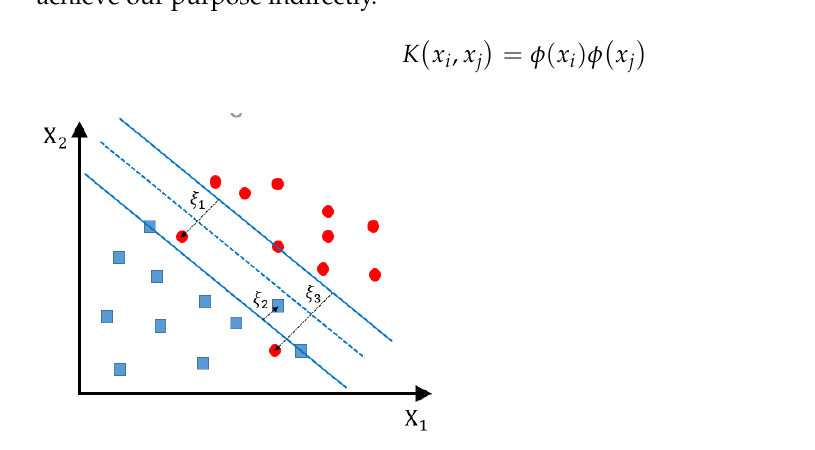
Figure 3. Sketch of soft classification and nonlinear classification based on SVM. Figure 3. sketch of soft classi fi cation and nonlinear classi fi cation based on SVM